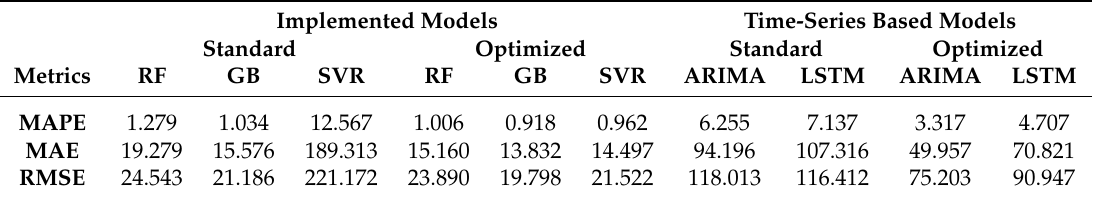
Table 8. Mean of MAPE (%), MAE (GWh), and RMSE (GWh) over the test data (2018) for all the evaluated models with default and optimized